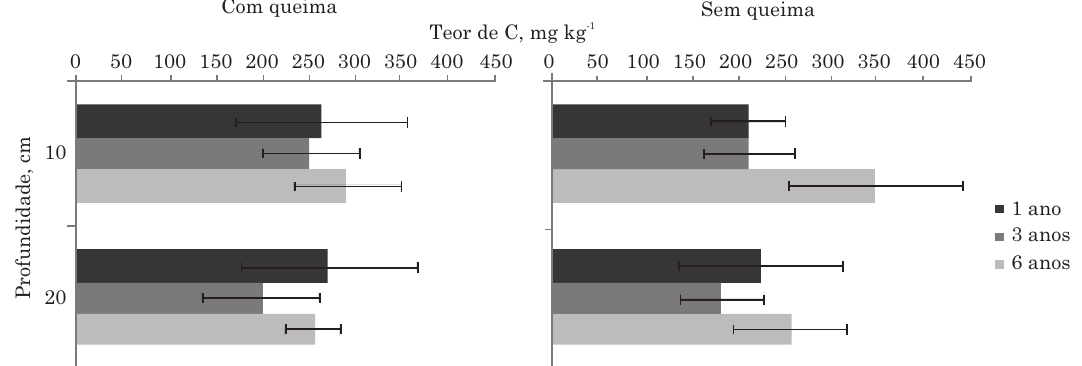
Figura 4. Teor de C microbiano em áreas de cana-de-açúcar em função do tempo, após a última reforma do canavial (p=0,95;